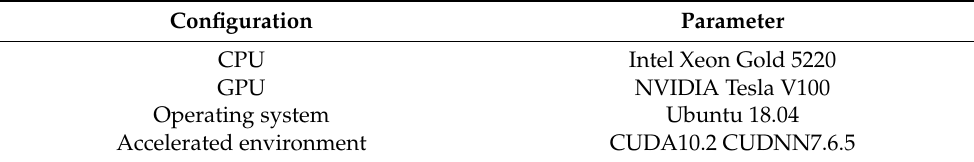
Table 1. Experimental environment.